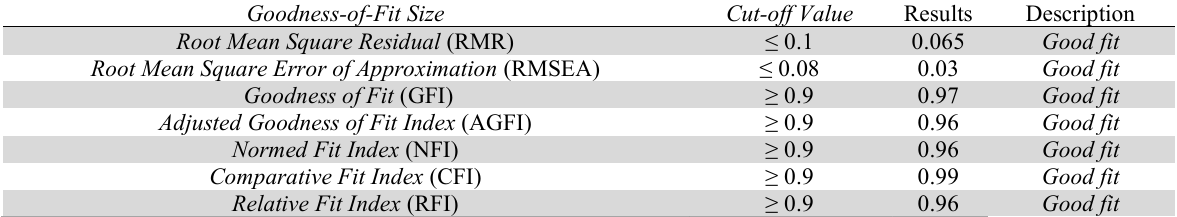
Goodness-of-Fit Test Results